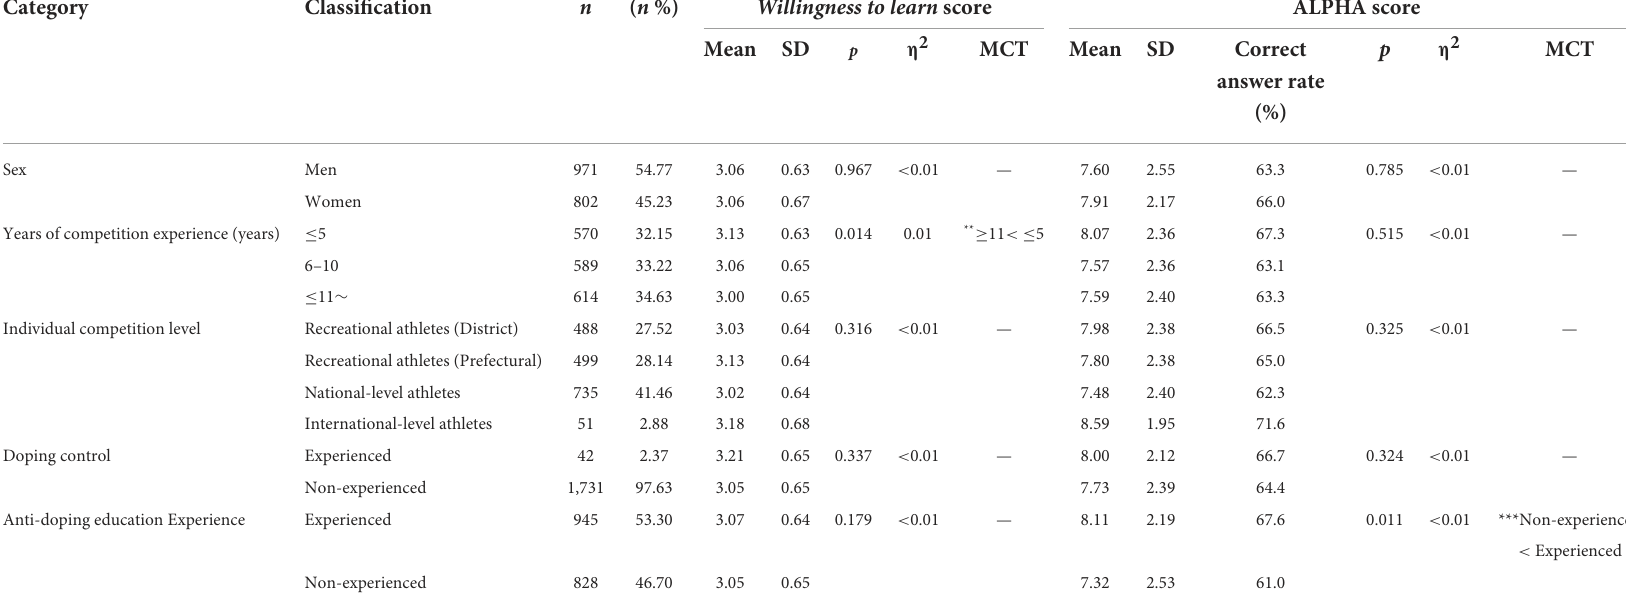
TABLE 2 Comparison of anti-doping willingness-to-learn score and ALPHA score by participants’ characteristics. Category Classification